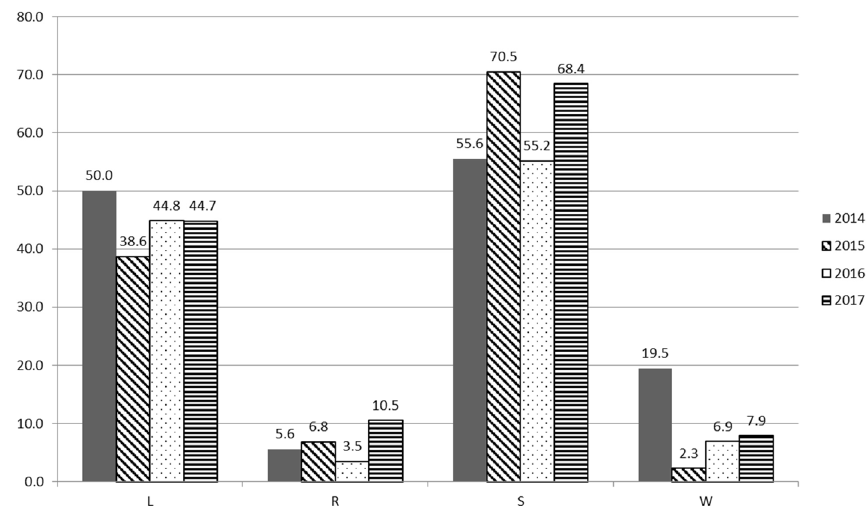
Fig. 2 Skills that those in the gap group thought received lower scores in TOEFL